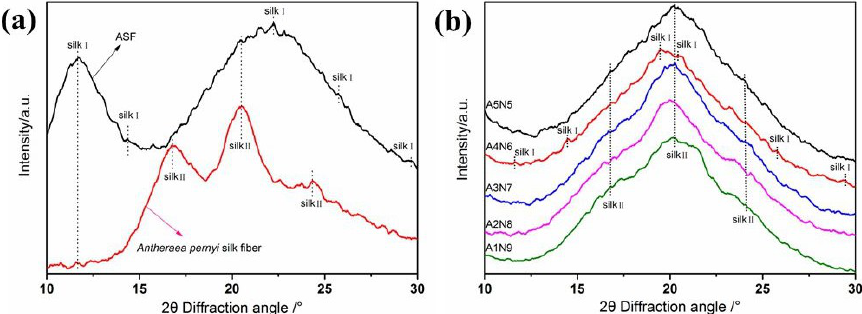
Figure 4. XRD graph of ( a ) A.pernyi silk fiber and ASF; ( b ) composite hydrogels of different ASF content.